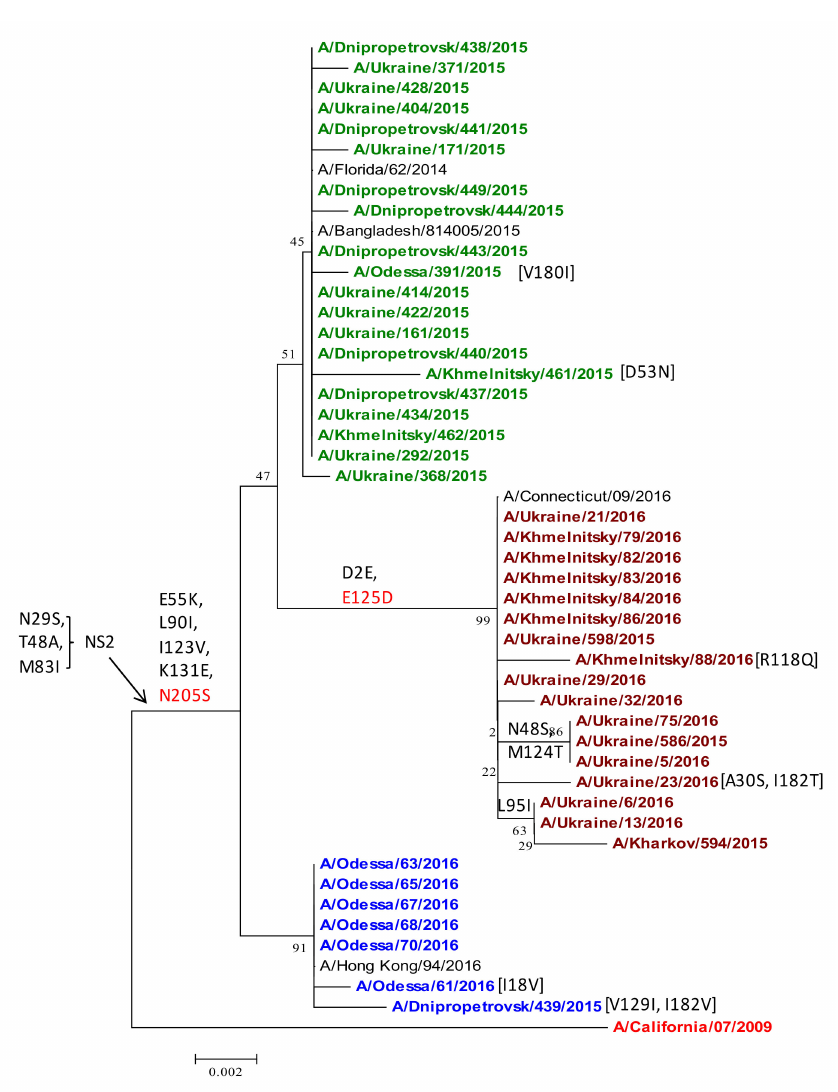
Figure 9. Phylogenetic comparison of A(H1N1)pdm09 influenza virus NS1 from the 2015/16 sea- son. NS1 nucleotide sequences were analyzed by NJ method, Kimura 2-parameter model, with 1000 bootstrap replications. The Ukrainian 2014/15 subgroup (green) was distinct from 2015/16 isolates (brown) and a separate subgroup (blue); reference strains are black, except the vaccine strain